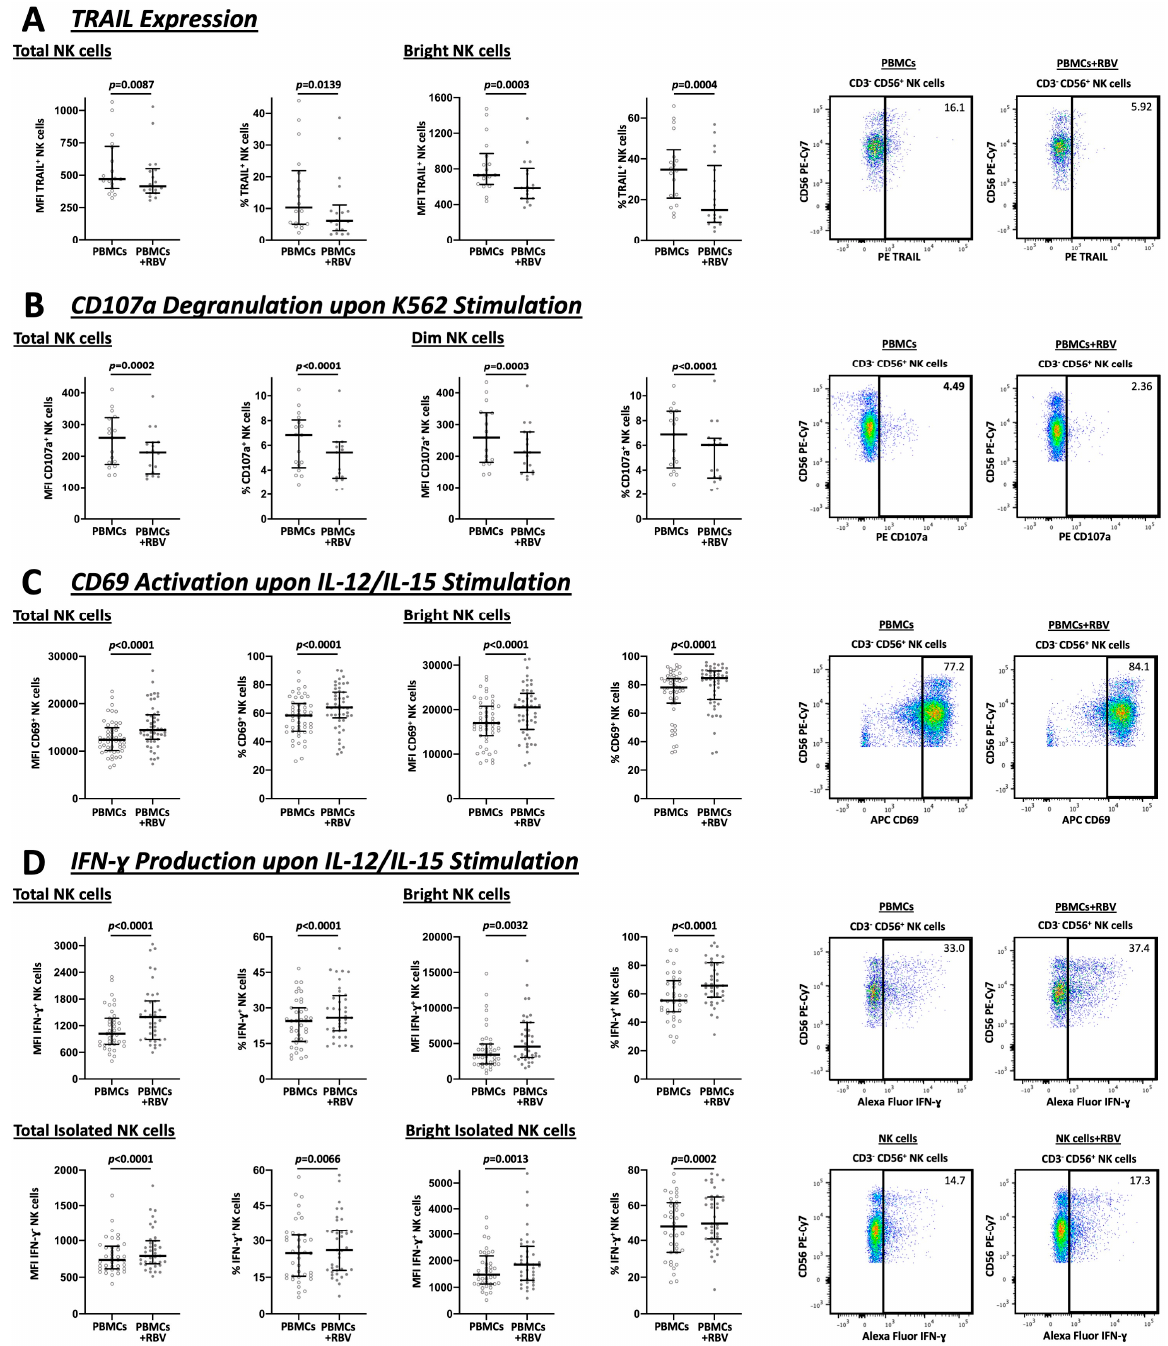
Figure 3. Flow cytometric analysis of total and bright or dim NK cells under RBV treatment with exemplary gating strategy. MFI and frequencies compared. ( A ) Expression of TRAIL by NK cells (n = 18). ( B ) NK cell degranulation analyzed by CD107a expression upon K562 stimulation (n = 17). ( C ) Activation of NK cells represented by CD69 expression upon IL-12/IL-15 stimulation (n = 51). ( D ) Analysis of IFN- γ upon IL-12/IL-15 stimulation as a major indicator for NK cell cytokine production (n = 39). Appearance: median with interquartile range, statistical analysis: Wilcoxon matched-pairs signed-rank